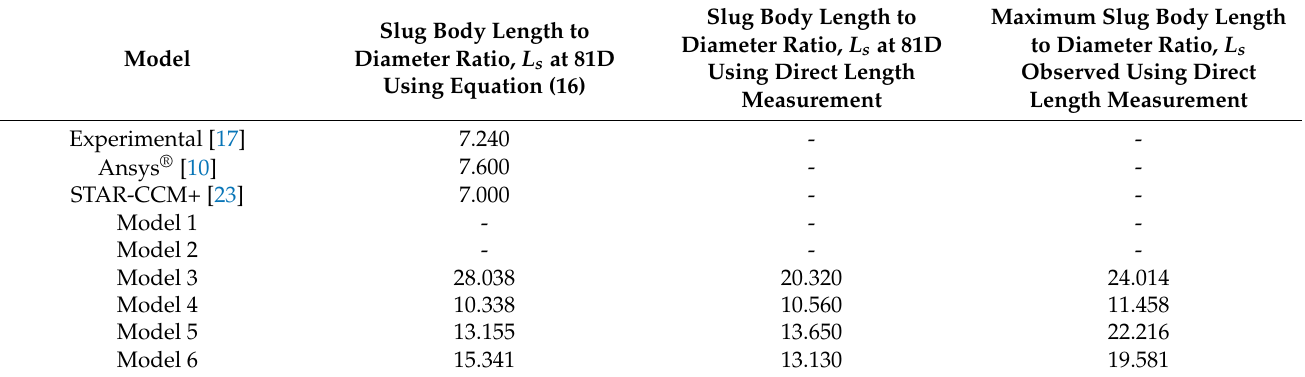
Table 6. Slug body length to diameter ratio, L s for each